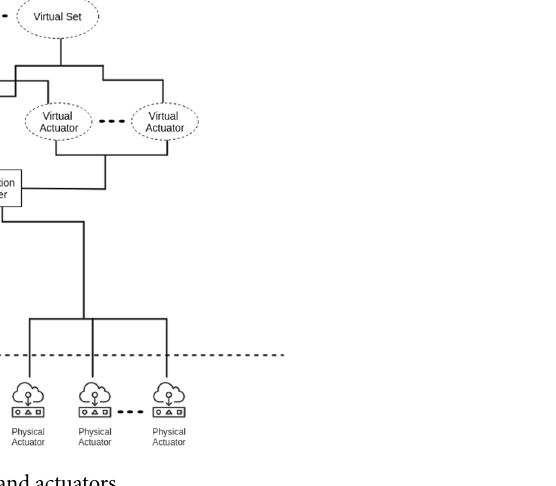
Figure 3. Virtualizing sensors and